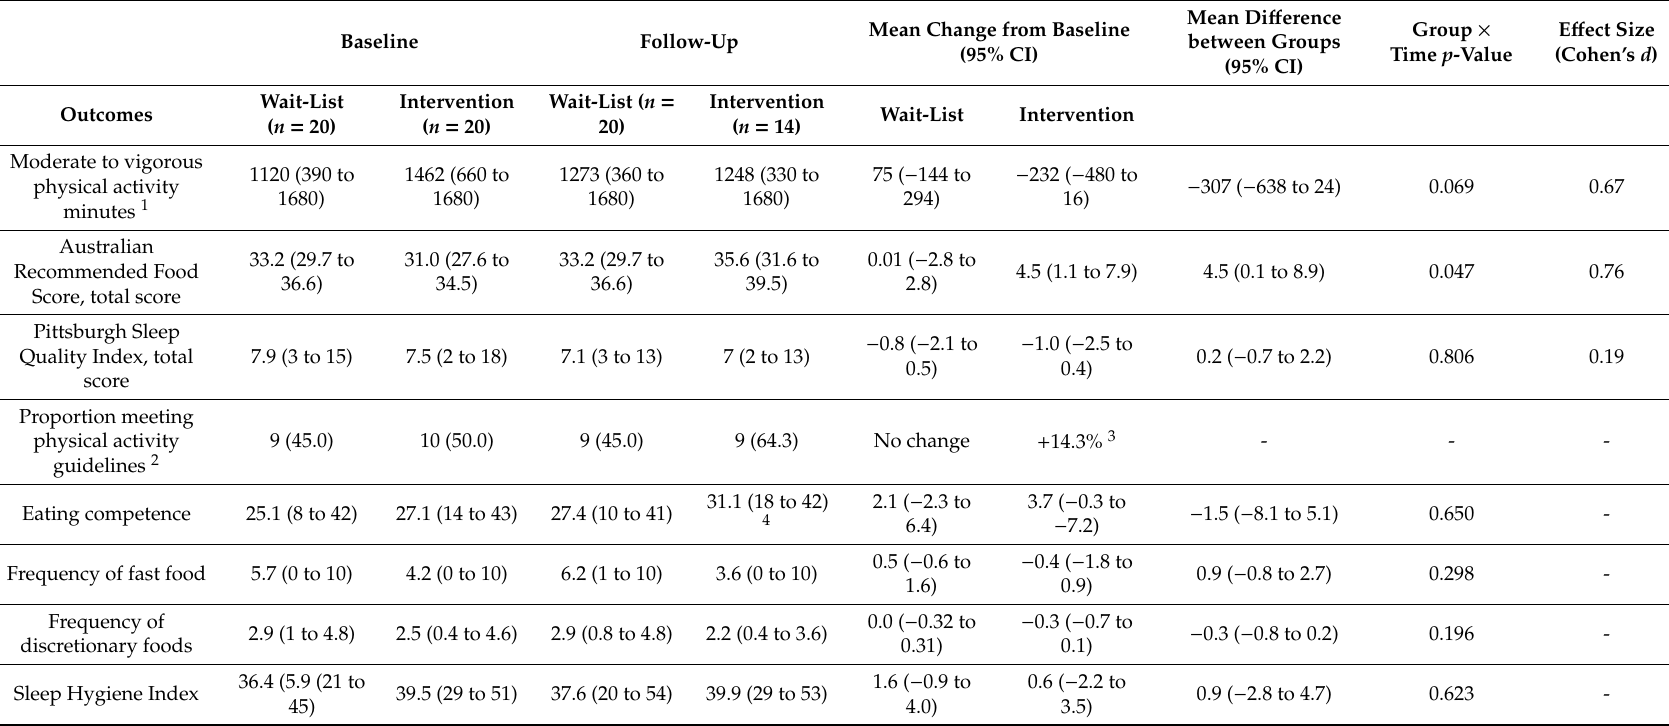
Table 4. Estimation of intervention e ff ect, mixed model analysis (intention-to-treat).